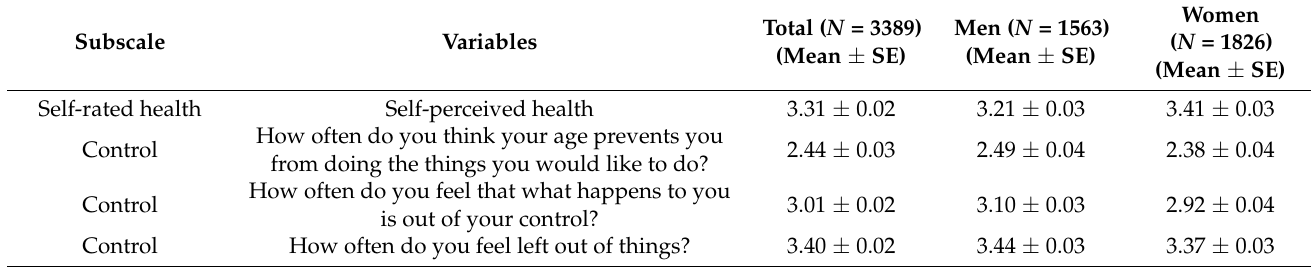
Table 1. Variables selected from the SHARE questionnaire: mean and standard deviation.